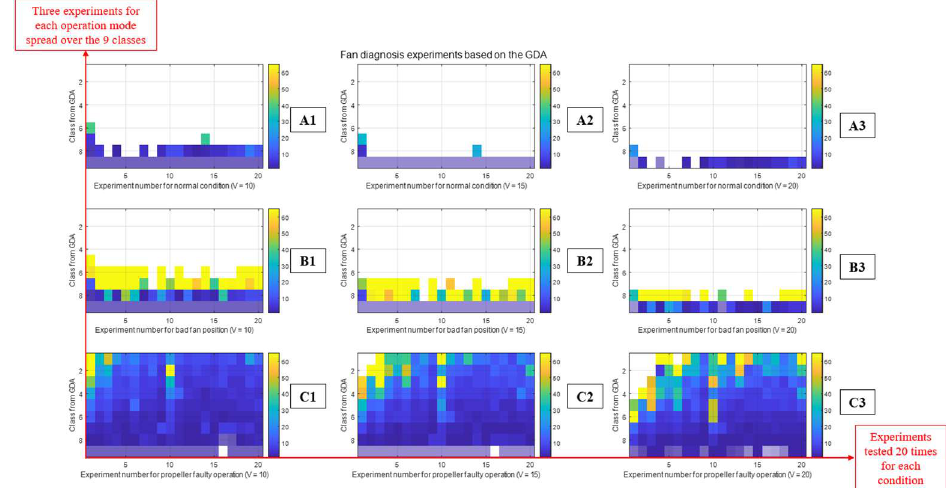
Figure 13. Experiments repeated twenty times to validate the GDA approach. A1 to A3 are the twenty normal test conditions for the three values of V with A1 for V = 10, A2 for V = 15 and A3 for V = 20. B1 to B3 are for the twenty tests for bad fan position and C1 to C3 are for propeller faulty condition.